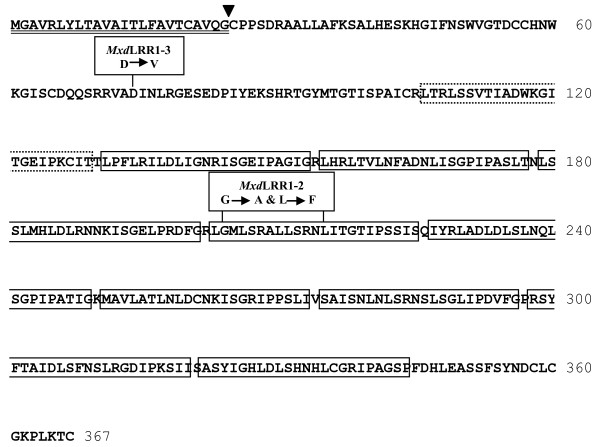
Sequence and structure ofMalusleucine-rich repeat family receptor-like polypeptide. Predicted translation product of the MxdRLP1-1 allele cloned from cultivars ‘Malling 26’, ‘Malling 27’ and ‘Robusta 5’. A predicted signal peptide cleavage site is indicated by an inverted arrowhead, and the signal peptide is double underlined. Nine consensus (LXXLXXLXLXXNXXαGXαPXXαG, where α represents any hydrophobic amino acid substitution [105]) LRR elements are boxed; the tenth degenerate element is boxed with a dotted line. The two mutated alleles isolated from cultivar ‘G.41’ are shown in boxes above the corresponding sequence.